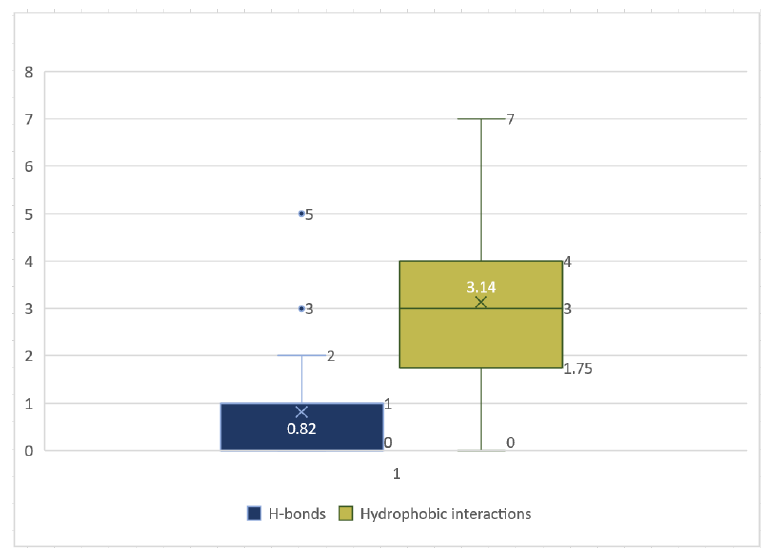
Figure 6 . A box-whisker plot represents an excellent graphical image of the concentration of the data of the number of hydrogen and hydrophobic bonds among amino acid residues of the COVID-19 substrate binding site to the newly synthesized SB derivatives 5a ‒ g as a result of the docking analysis carried out, S1 .